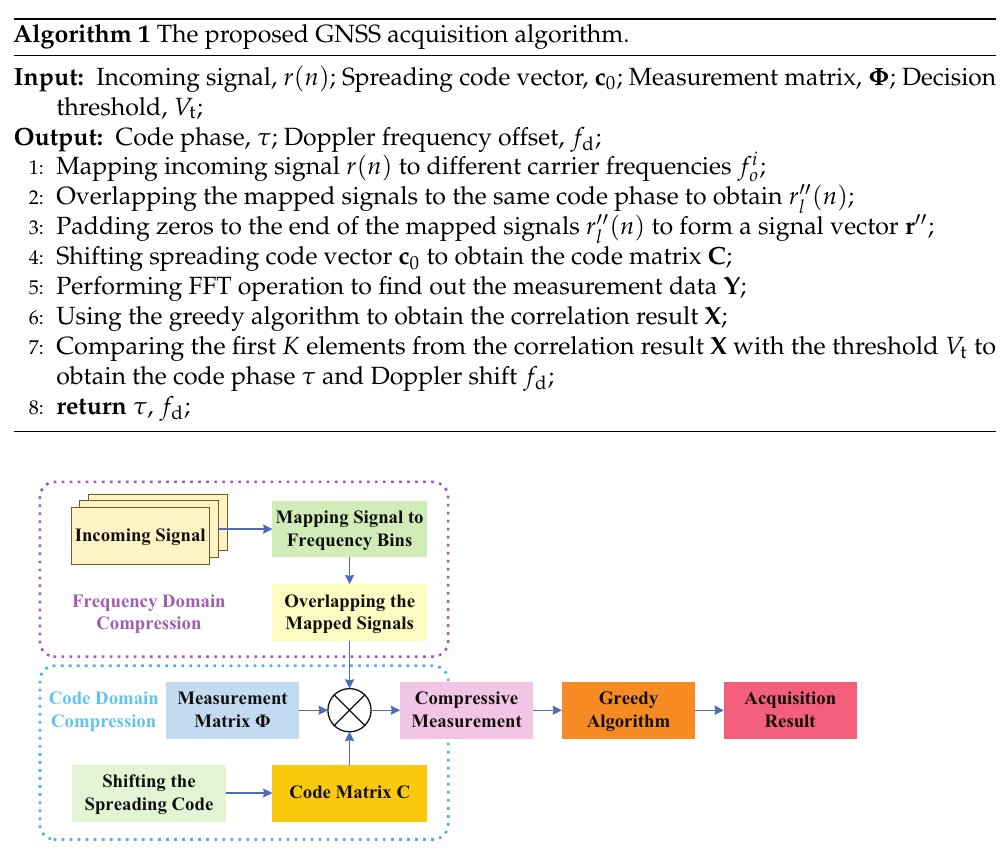
Figure 4. GNSS signal acquisition based on code-frequency